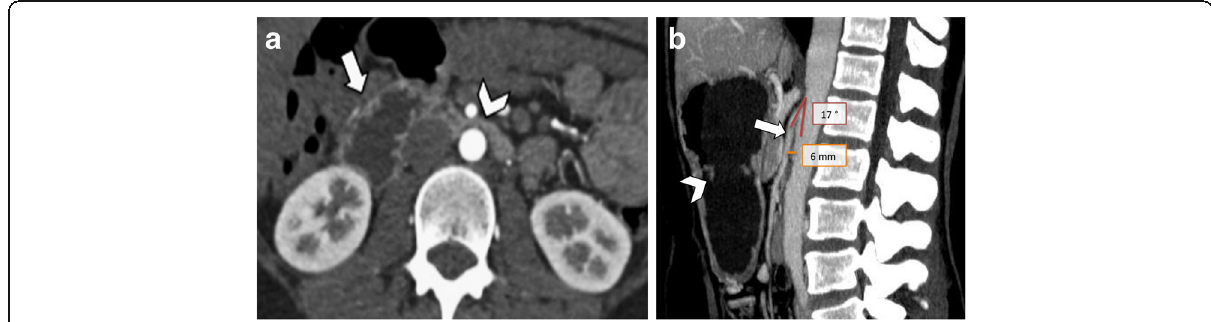
Fig. 11 A 48-year-old woman with superior mesenteric artery syndrome. a Axial CT image on the arterial phase shows dilatation of the second portion of the duodenum (arrow), due to the compression of the third portion (arrowhead) between the abdominal aorta and the SMA. b Sagittal CT image of the abdomen shows gastric dilatation (arrowhead) caused by compression of the third portion of the duodenum between the abdominal aorta and the SMA (arrow). This sagittal reconstruction also allows measurement of aortomesenteric angle (17°) and aortomesenteric distance (6 mm), values diagnostic for mesenteric artery